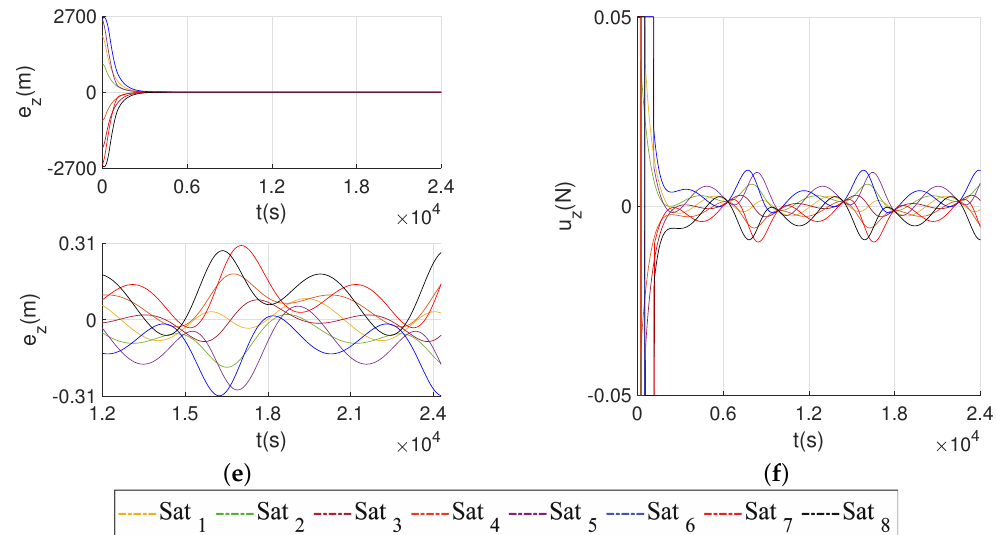
Figure 6. PD law. Error and control time histories: ( a ) errors along axis x; ( b ) controls along axis x; ( c ) errors along y; ( d ) controls along y; ( e ) errors along axis z; ( f ) control along axis z.